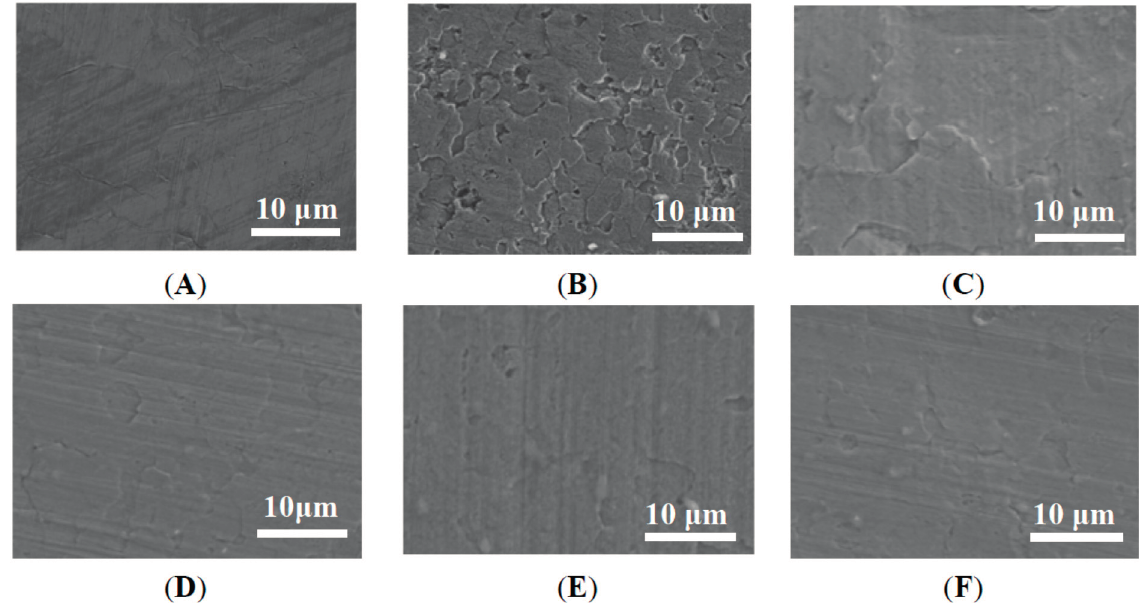
Figure 7. SEM images of uncoated Zn plate ( A ) before; and ( B ) after corrosion, Zn palate protected GNS-based epoxy resin coating with various content of ( C ) 0; ( D ) 0.1 wt %; ( E ) 0.4 wt %; and ( F ) 0.7 wt